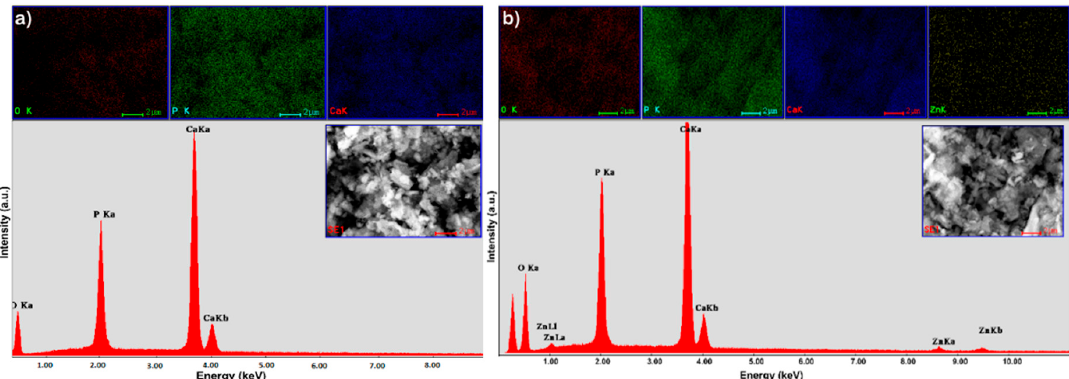
Figure 4. EDX spectrum and elemental mapping of synthetized HAp ( a ); and EDX spectrum and elemental mapping of hydroxyapatite recovered after zinc adsorption from aqueous solutions (HApD) containing concentration of 50 mg/L zinc ions ( b ).